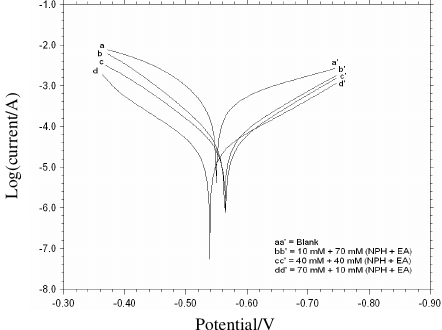
Figure 2. Potentiodynamic polarization curves in absence and in presence of the binary inhibitor mixtures of NPH and DMA at different concentration ratio